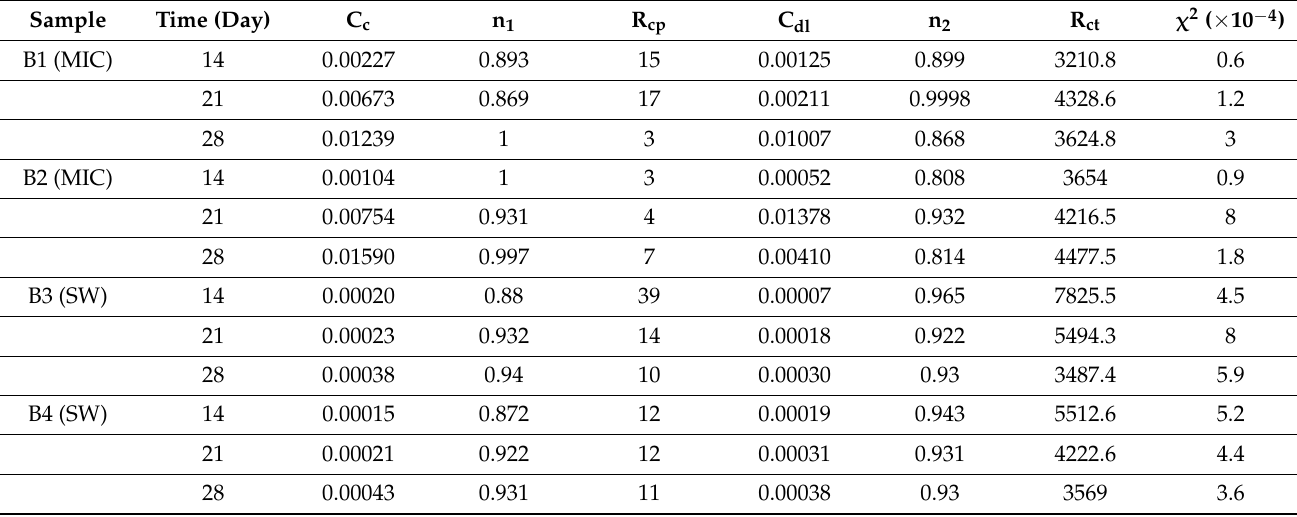
Table 6. Parameters and fitting results of the impedance data using an equivalent circuit, R in Ω · cm 2 and C in (F · cm − 2